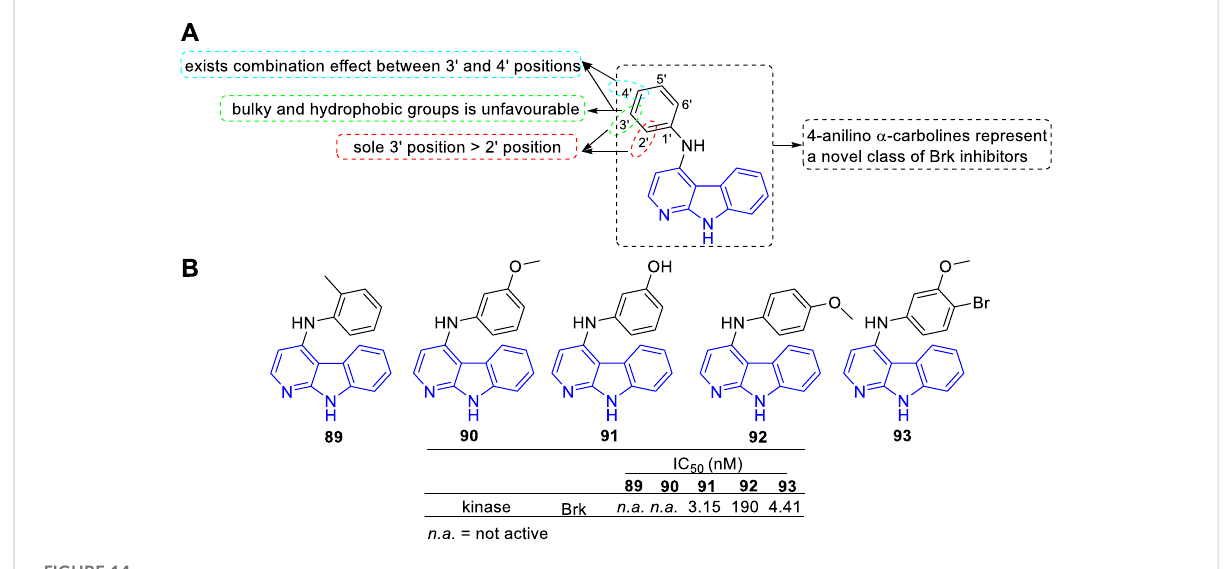
FIGURE 14 (A) SARs of 4-anilino α -carbolines as Brk inhibitors; (B) Structures and bioactivity of the representative compounds 89 – 93 .